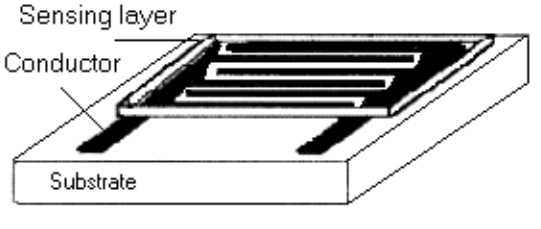
Figure 16. The sensor